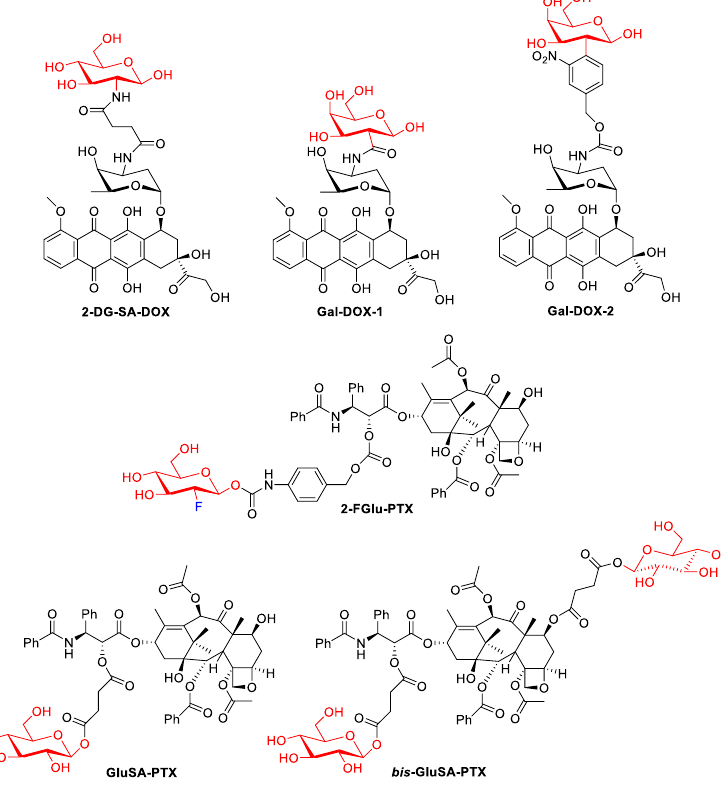
Figure 3. Representative DOX glycoconjugates and PTX glycoconjugates.